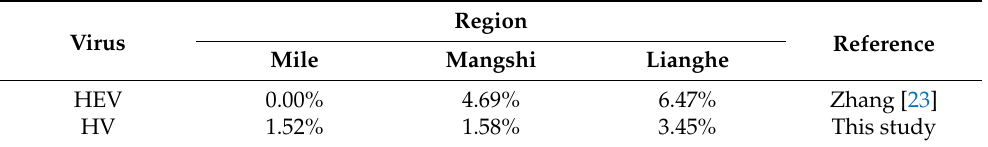
Table 3. The infection rates of HEV and HV among murine-shaped animals in Yunnan Province, China. Region Virus Reference Mile Mangshi Lianghe HEV 0.00% 4.69% 6.47% Zhang [23] HV 1.52% 1.58% 3.45% This